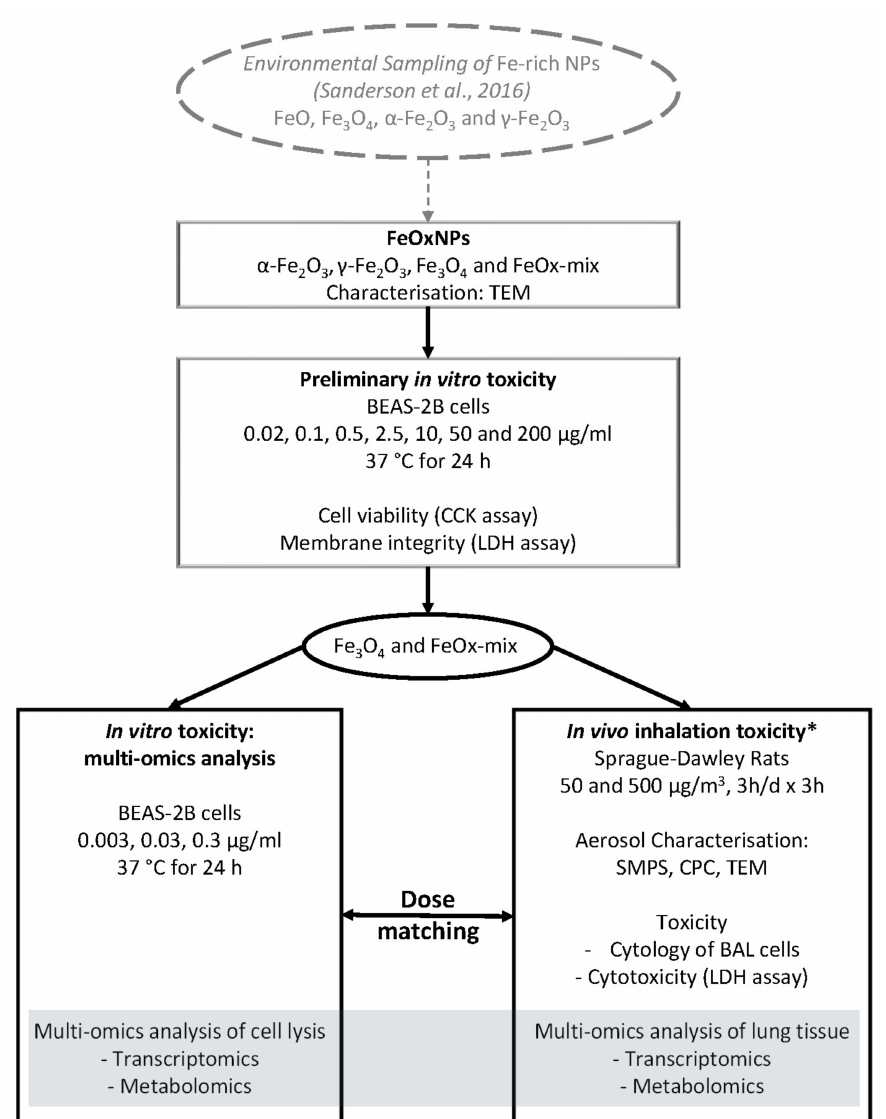
Figure 1. Pulmonary toxicity of environmentally relevant FeO x NPs: Study design. (*